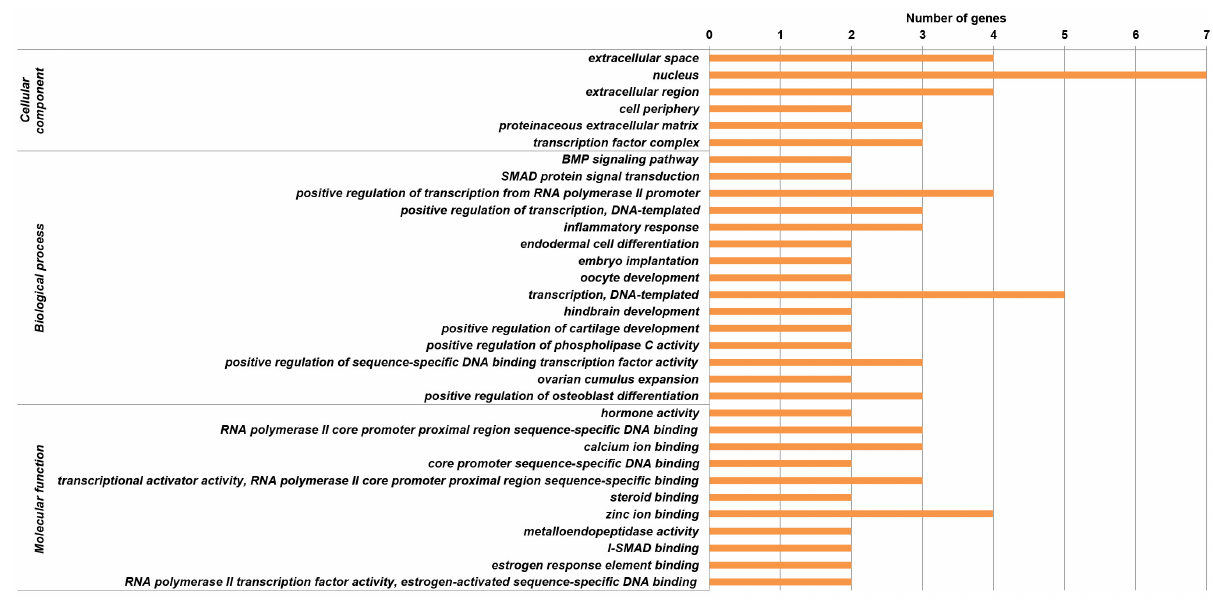
FIGURE 6 | Gene ontology (GO) enrichments based on the functional genes surrounding the significant SNPs at the chromosome-wise 5% level.